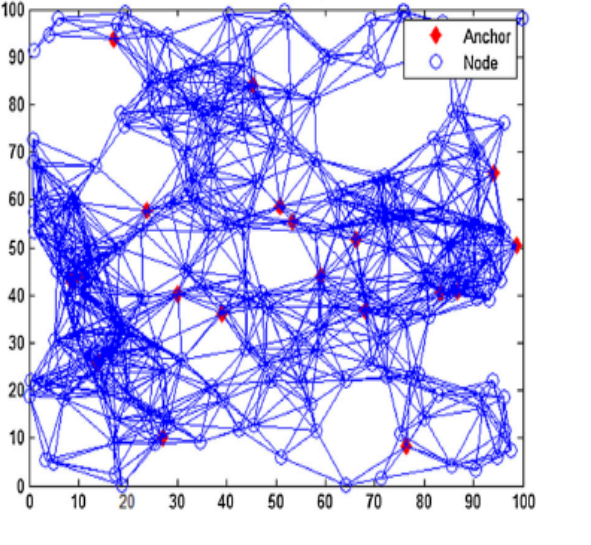
10 of 16 Figure 4. Correction of UN coordination position.